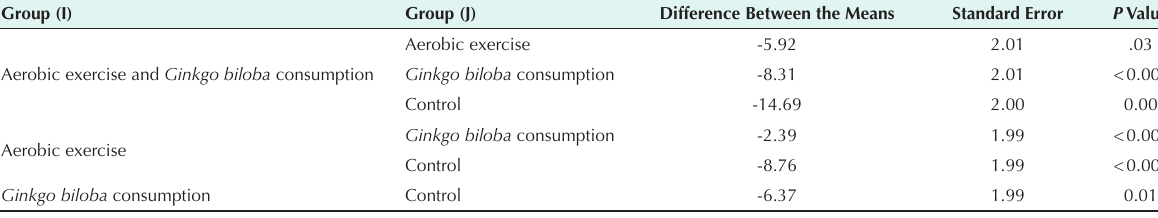
Table 4. Findings of Bonferroni Test Concerning Lipocalin 2 Group